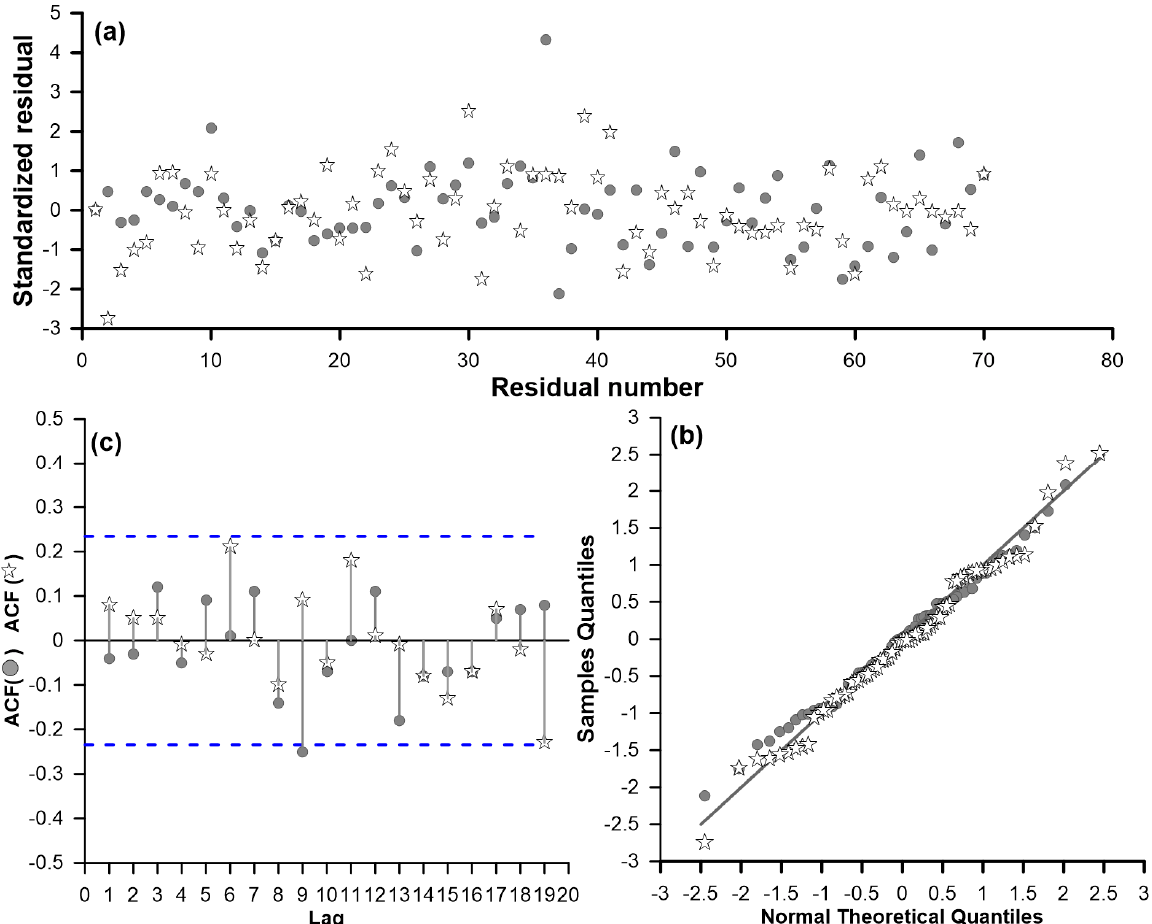
Figure 5. Residual analysis of the selected ARIMA model for earthquakes number time series (circles) and for annual maximum magnitudes time series (stars). ( a ) residuals of the selected models; ( b ) ACF residual plots, indicating that the residuals of the two models are uncorrelated; ( c ) residuals are normally distributed according to the residuals Quantile-Quantile plots (Q-Q plot).